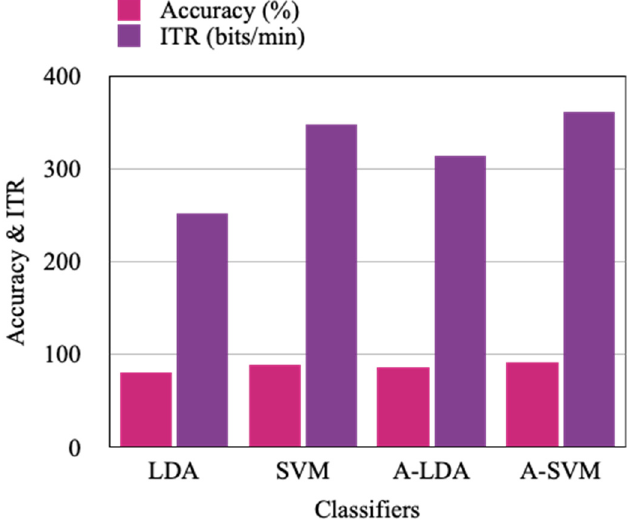
Figure 10. Subjects’ average classification comparison in terms of accuracy and ITR.